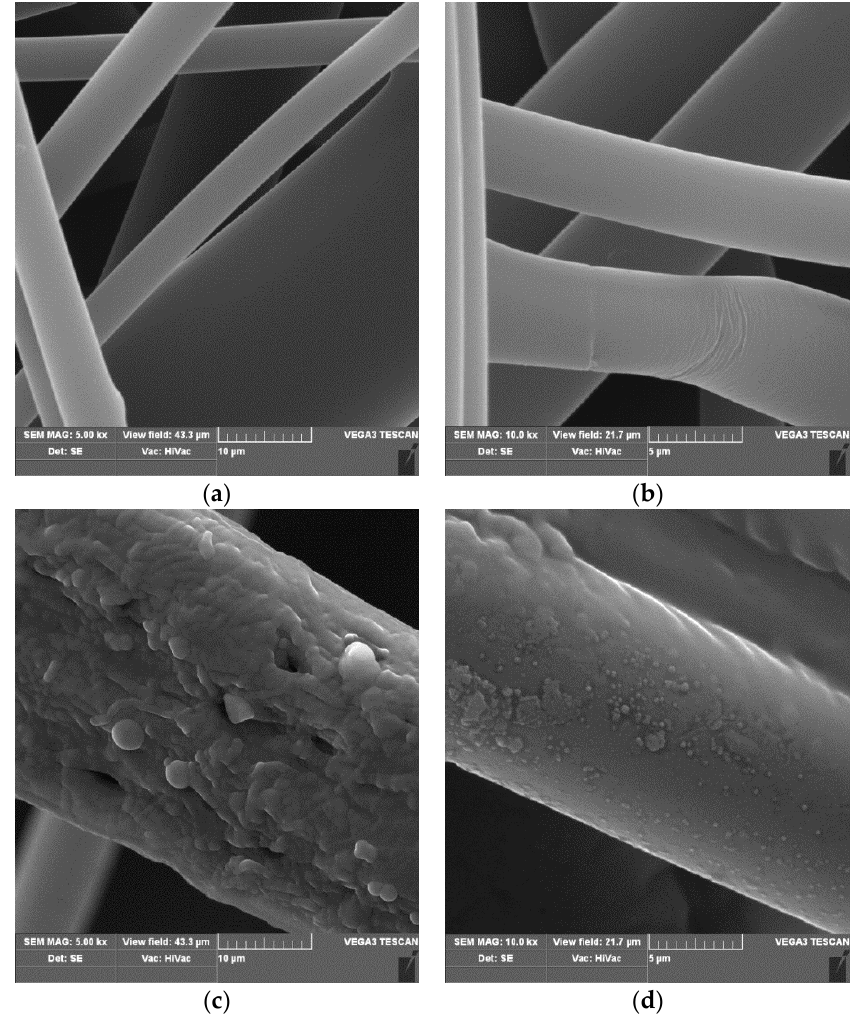
Figure 2. SEM spectra of polypropylene nonwoven (PP) ( a , b ) and polypropylene nonwoven with phosphonodipeptide modifier ( c , d ), taken at magnifications 5.00 k × (5 × 10 4 ) (left) and 10.0 k × (10 × 10 4 ) (right), respectively.